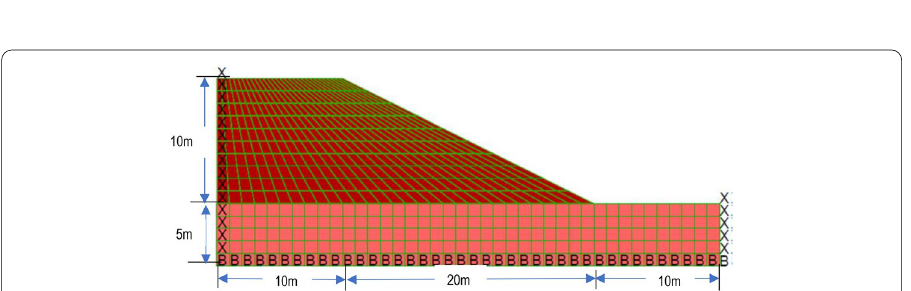
Fig. 5 Geometry and finite difference grid for the embankment